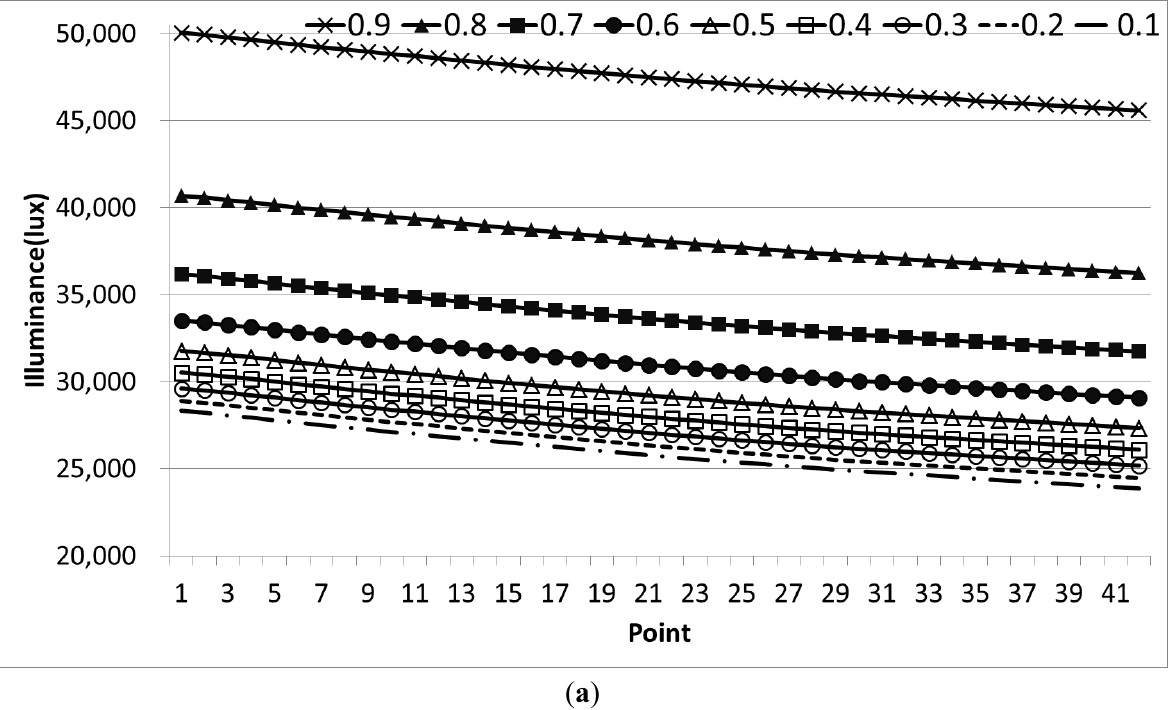
Figure 8. Winter solstice condition shows different trends in illuminance results [21]: ( a ) illuminance level using the Split-flux method [21]; ( b ) illuminance level using the Radiosity method